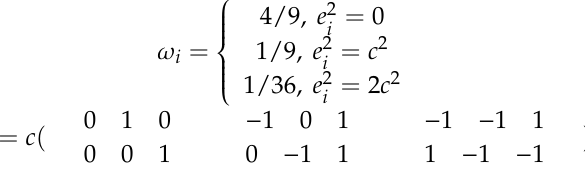
Figure 2. NACA0012 airfoil grid point type judgment diagram.